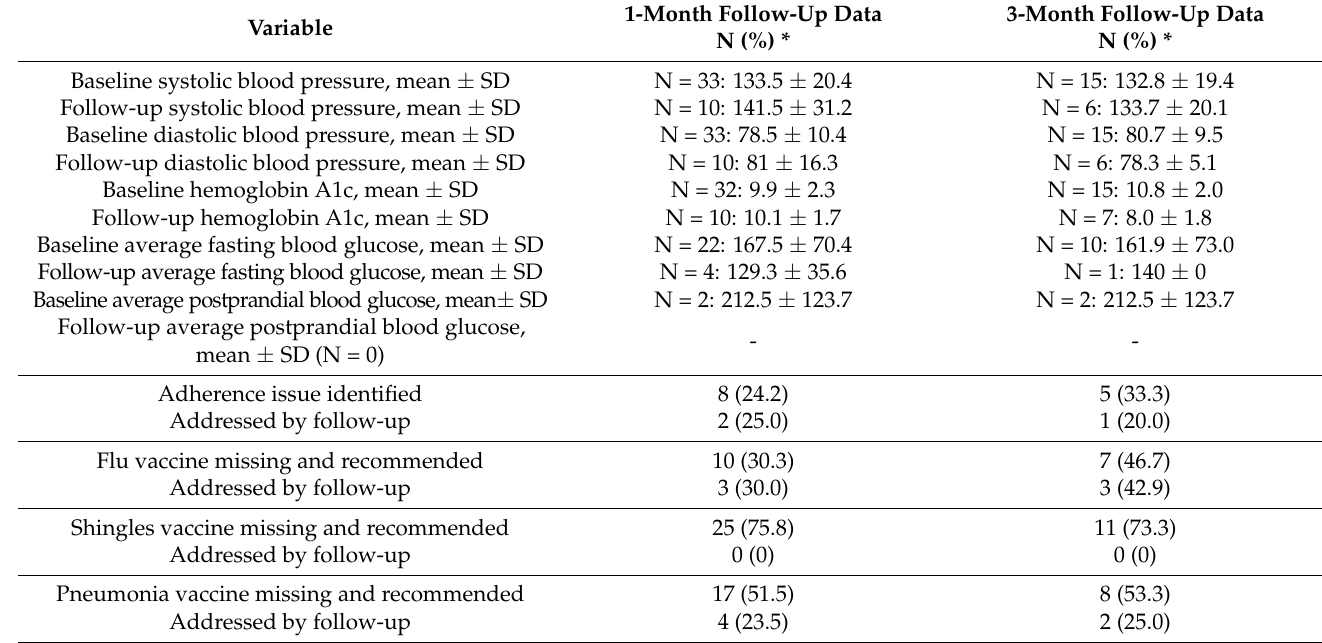
Table 2. Variables with baseline and 1-month follow-up data (N = 33) and 3-month follow-up data (N =